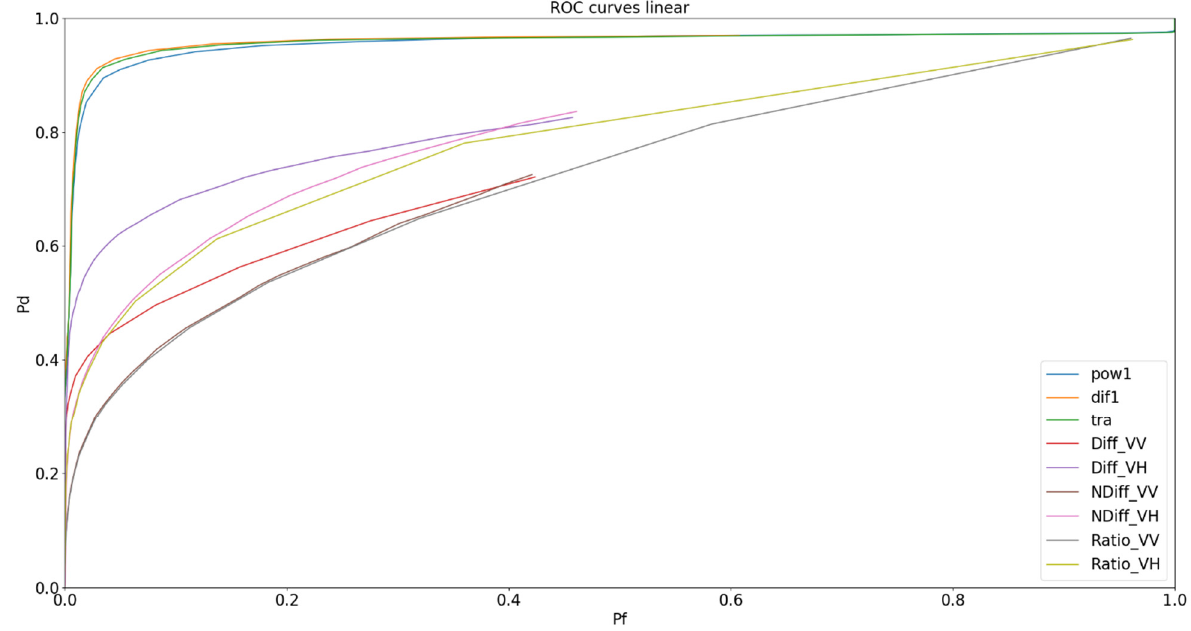
Figure 15. ROC curve in linear format showing change detectors used on 19 October 2019 paddy & 24 April 2020 data: Difference VV and VH (Diff_), Ratio VV and VH (Ratio_), Normalised Difference (NDiff_), Power Difference (Dif1), Power Ratio (Pow1) and Trace (HLT).